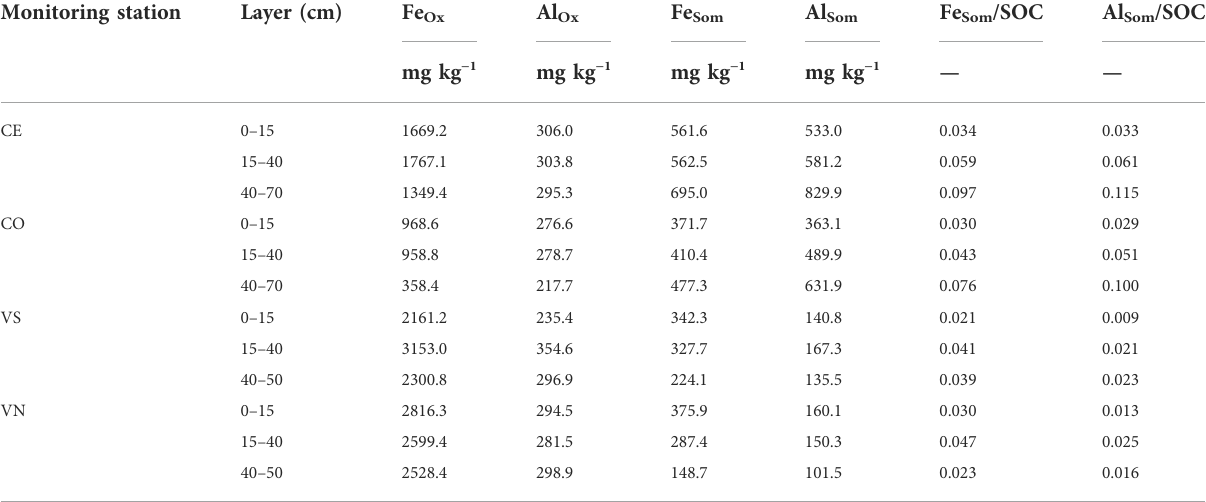
TABLE7Oxalate-extractable(Fe Ox andAl Ox )andSOM-chelated(Fe Som andAl Som )AlandFecontents(mgkg − 1 )inthefourmonitoringstationsandsoil depths. The ratio between Fe Som and Al Som and the SOC content (mg kg − 1 ) is also reported. Monitoring